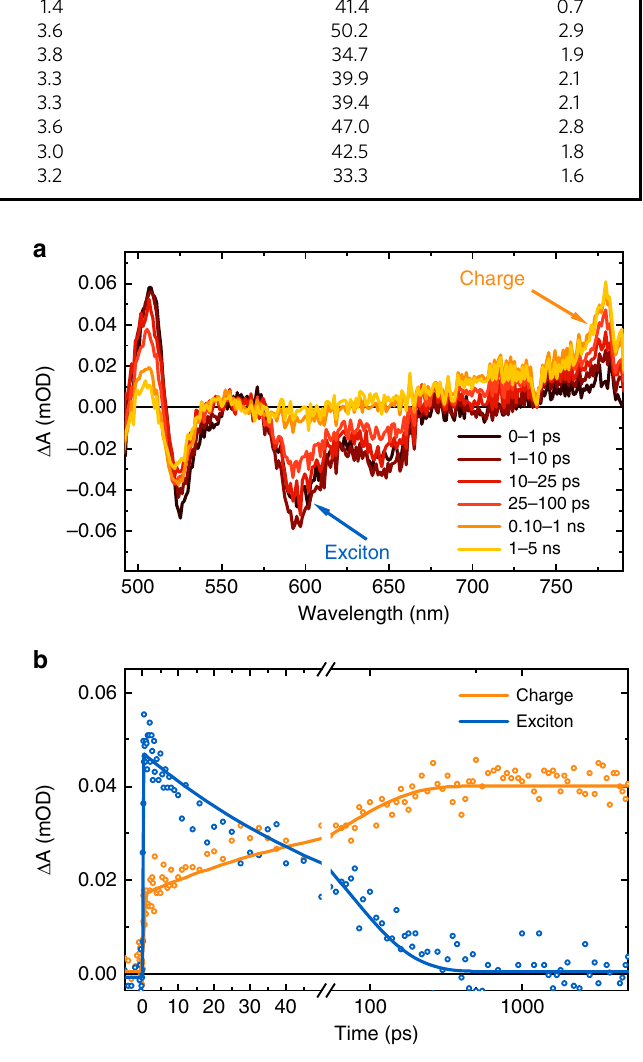
Fig. 2 Transient absorption (TA) characterisation for the pristine α -6T thin fi lm. a TA spectra for pristine α -6T thin fi lm employing a pump wavelength of 450nm; b TA kinetics at 593nm (blue) and 780nm (orange) representing stimulated emission (SE) and photoinduced absorption (PIA) signals, respectively, where the lifetimes of exciton decay and charge generation can be extracted from individual dynamics. The solid lines are exponential fi tting for the raw data (dots). Low (5 µ Jcm − 2 ) excitation fl uences were used to minimise exciton – exciton annihilation and bimolecular recombination processes (see Supplementary Figs. 6 and 8 for